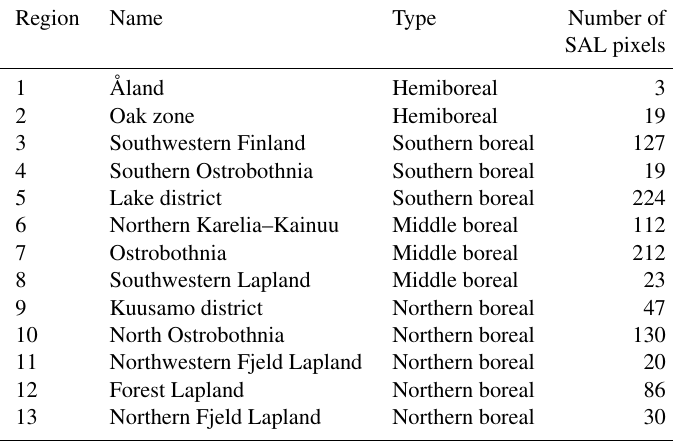
Table 1. The regions based on the vegetation zones of Finland.